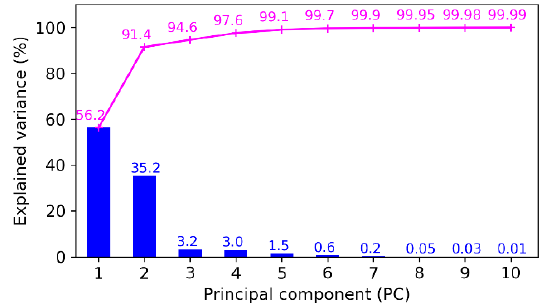
Figure 5. Bar diagram of explained variance versus PCs, and the line diagram shows cumulative variances of the groups of PCs for the AHN test data